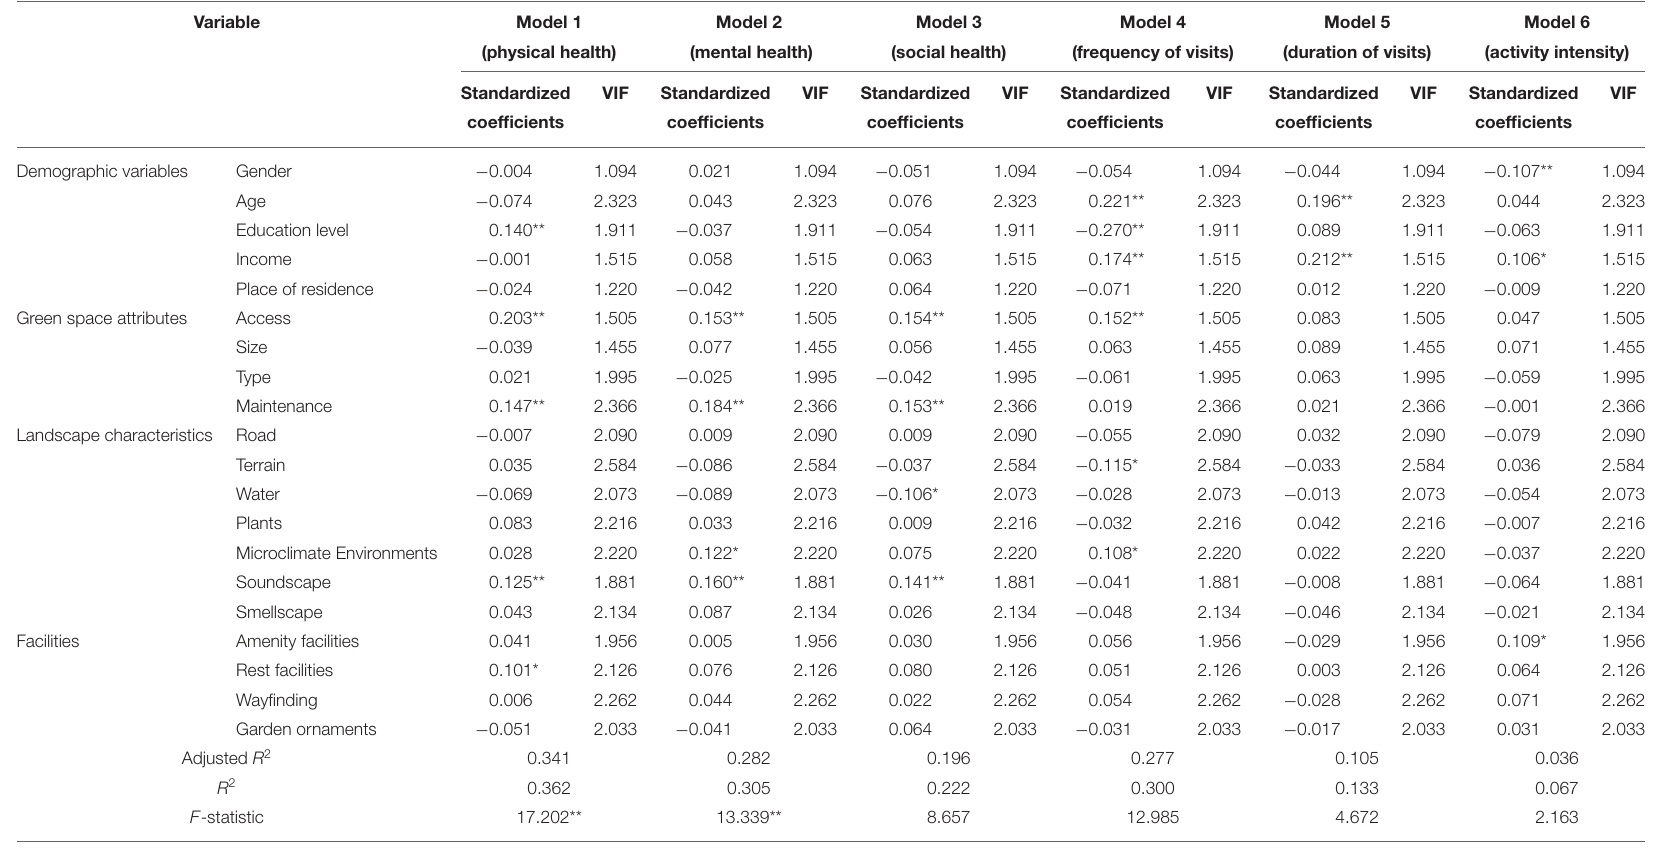
TABLE 5 | Multiple regression